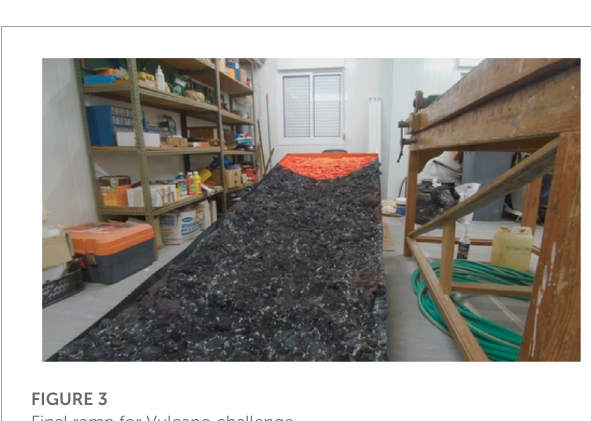
FIGURE 3 Final ramp for Vulcano challenge.